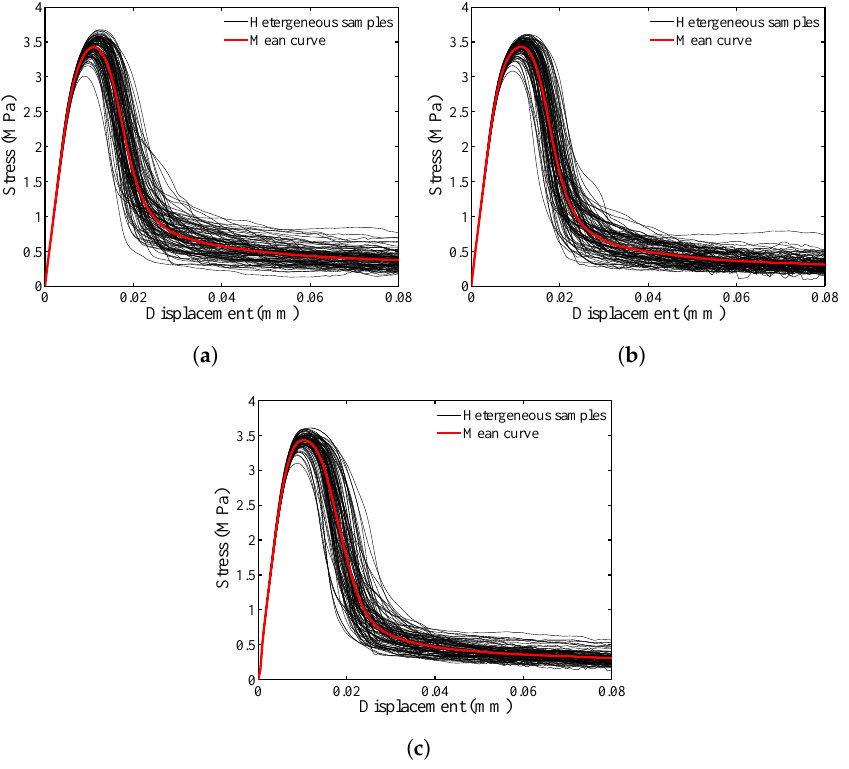
Figure 6. Tensile stress versus applied displacement for varying particle spacing. ( a ) h = 1/2 mm; ( b ) h = 1/3 mm; ( c ) h = 1/4